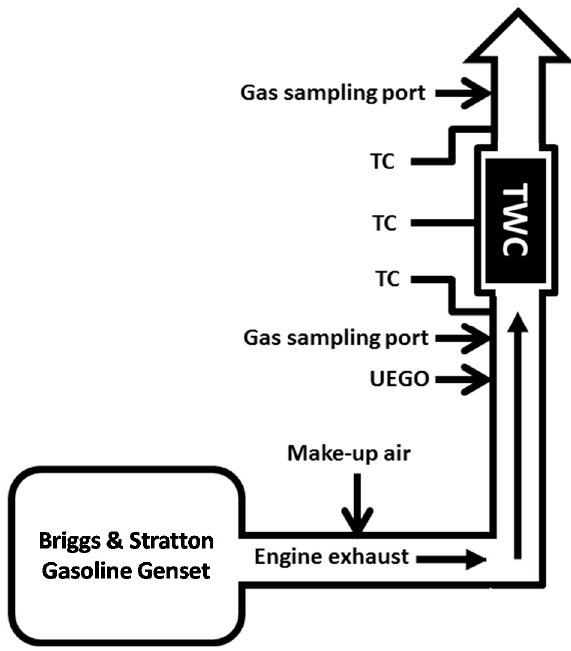
Figure 12. Schematic of the accelerated catalyst aging system using a gasoline genset.